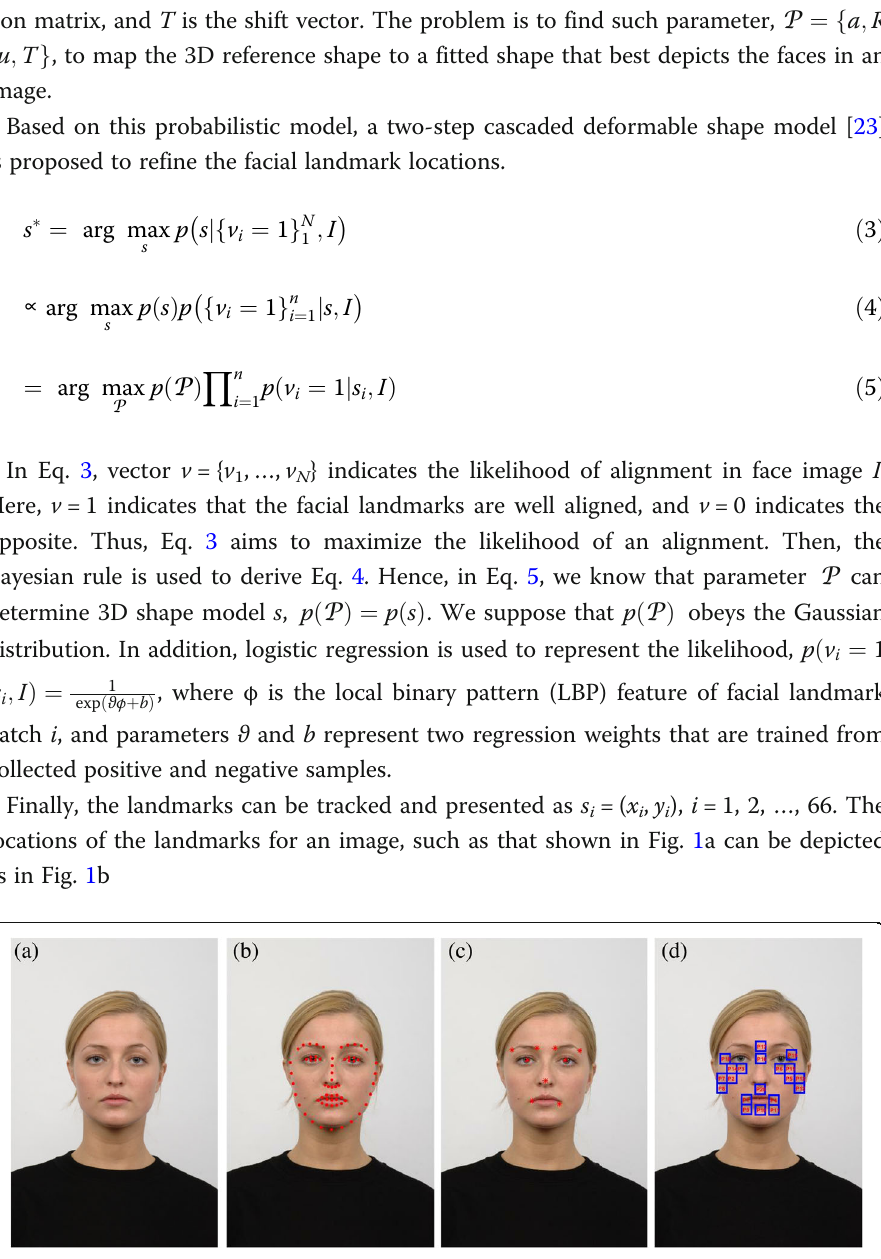
Fig. 1 Framework for automated extraction of salient facial patches. a Face image from RaFD database [25]. b Sixty-six facial landmarks detected using Yu et al. ’ s method [23]. c Points of lip corners and eyebrows. d Locations of the salient facial